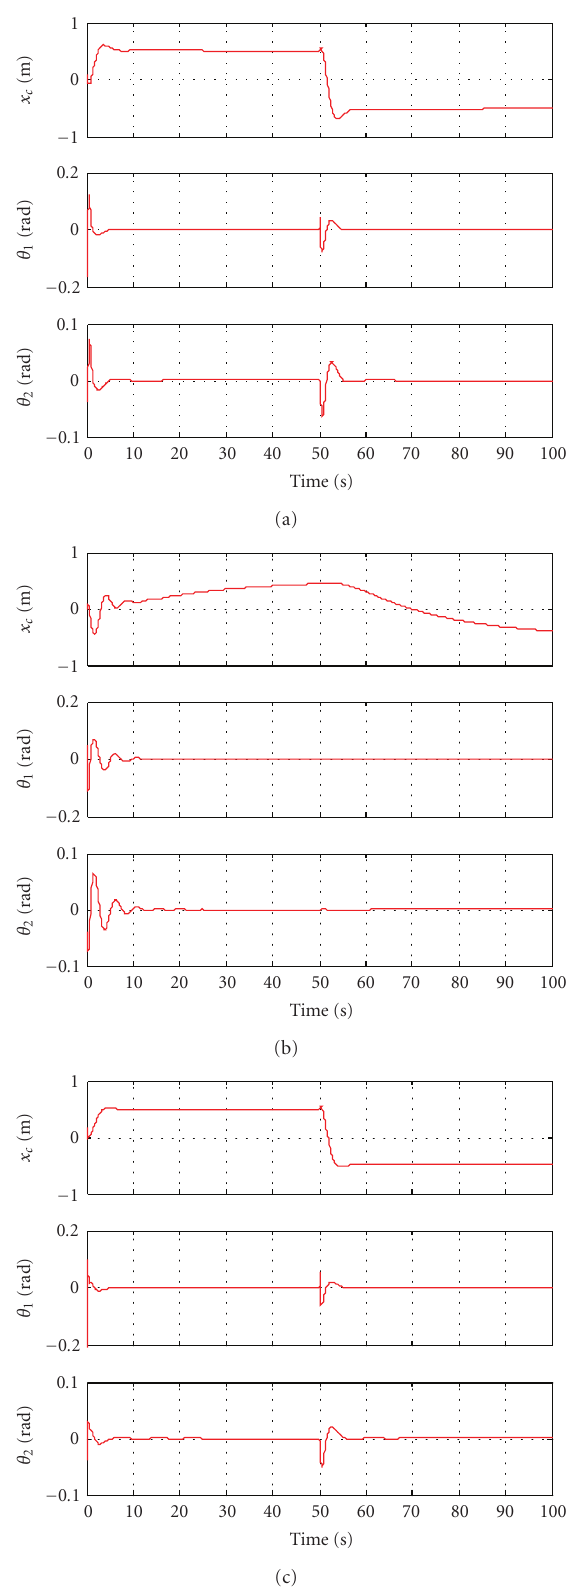
Figure 8: Nominal double inverted pendulum system responses of all controllers under healthy conditions. (a) —- FTCS, (b) ... H ∞ controller, and (c) - - - μ